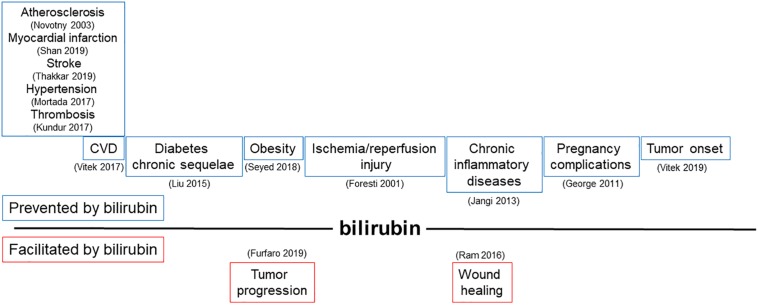
Modulation of bilirubin production can affect a broad range of pathologies driven by endothelial dysfunction. Schematic representation of pathophysiological processes influenced by the ability of bilirubin to modulate endothelial function. In the upper part, diseases prevented by bilirubin are shown; in the lower part, conditions favored by locally generated bilirubin are indicated. References in brackets.